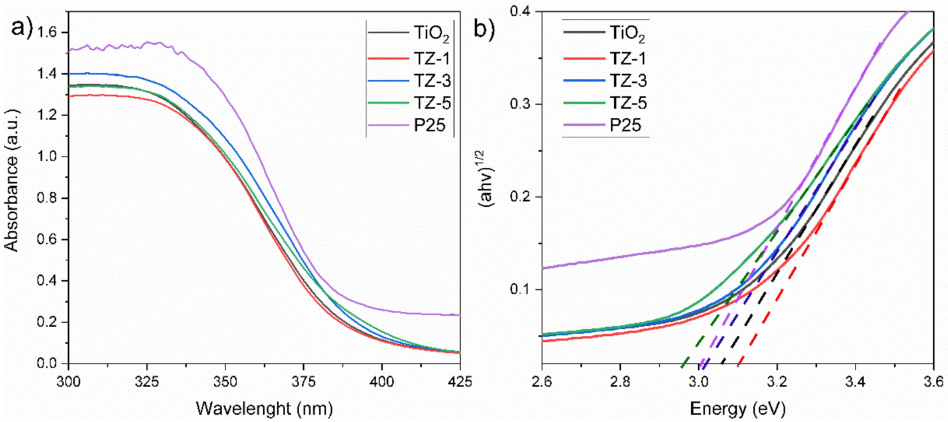
Figure 5. UV–Vis spectra of nanocomposites ( a ), and Tauc’s plot ( b